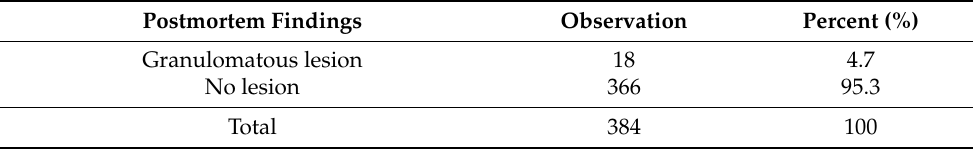
Table 3. Lesion description based on routine and detailed postmortem inspection.